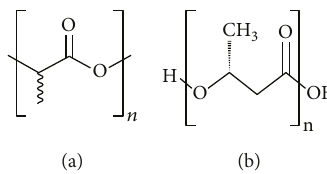
Figure 1: (a) PLA and (b) PHB chemical structure.